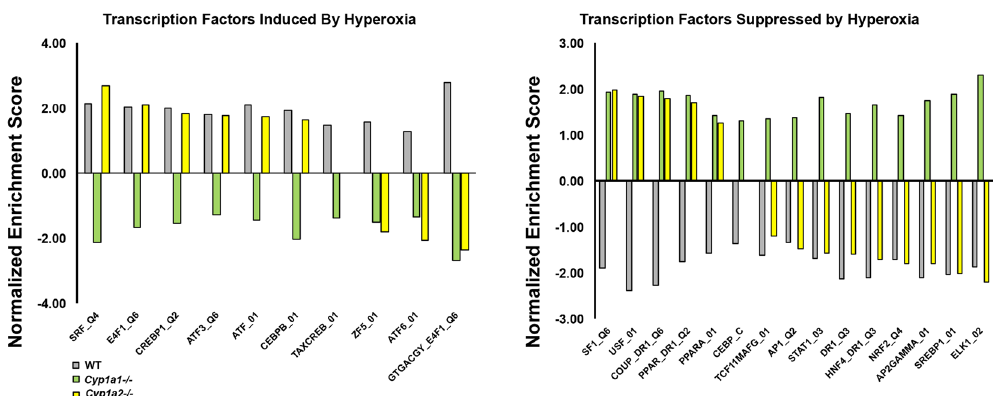
Figure 4. Gene Set Enrichment Analysis (GSEA) reveals distinct modulation of transcriptional regulators between WT, Cyp1a1 − / − , and Cyp1a2 − / − mice exposed to hyperoxia. Enrichment of transcriptional regulators in the transcriptomic response of three (WT, Cyp1a1 − / − and Cyp1a2 − / − ) genotypes after exposure to hyperoxia was assessed using GSEA. An extensive search was carried out for transcriptional regulators that were enriched after hyperoxia exposure (Q < 0.25) but with targets changed in opposite direction in WT mice compared to either Cyp1a1 − / − or Cyp1a2 − / − (NES has opposite signs for hyperoxia response in either Cyp1a1 − / − or Cyp1a2 − / − compared to the hyperoxia WT mice). We report separately transcriptional regulators with a positive NES (acting primarily as transcriptional activators for WT mice hyperoxia) and those with a negative NES (acting primarily as transcriptional repressors for WT mice